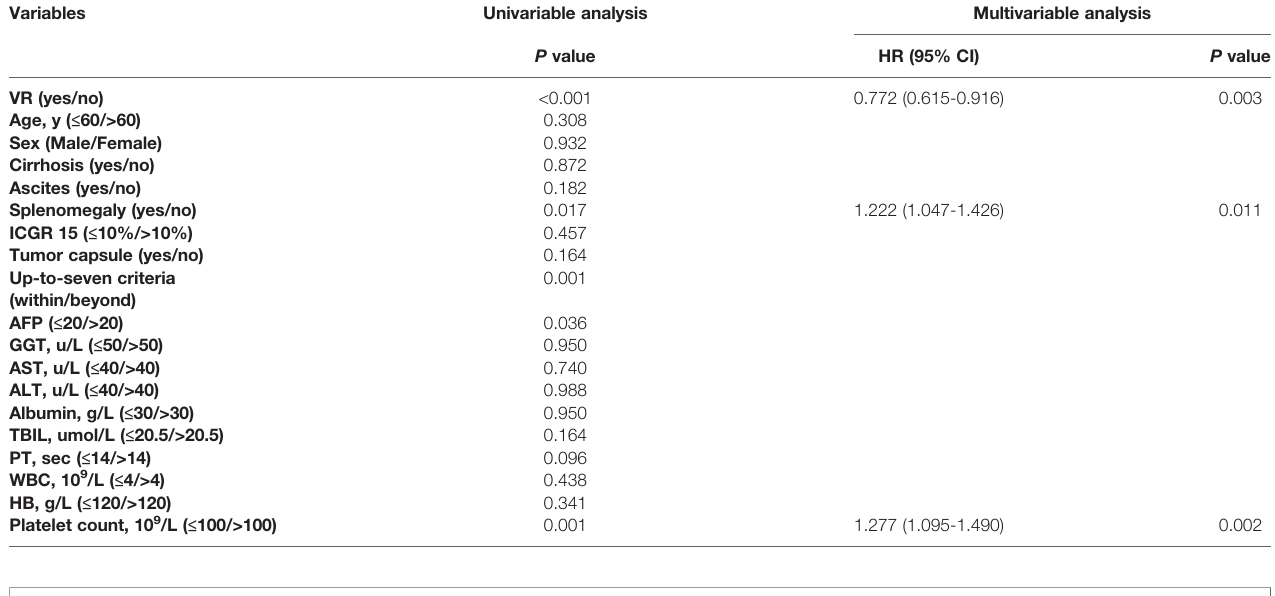
TABLE 5 | Univariable and multivariable analysis of OS in patients with NA